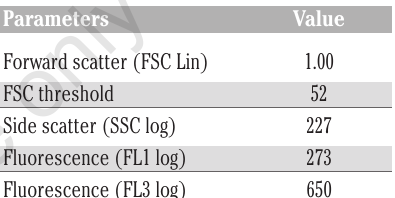
Table 1. Approximate parameters used for acquisition of phagocytosis Data by flow